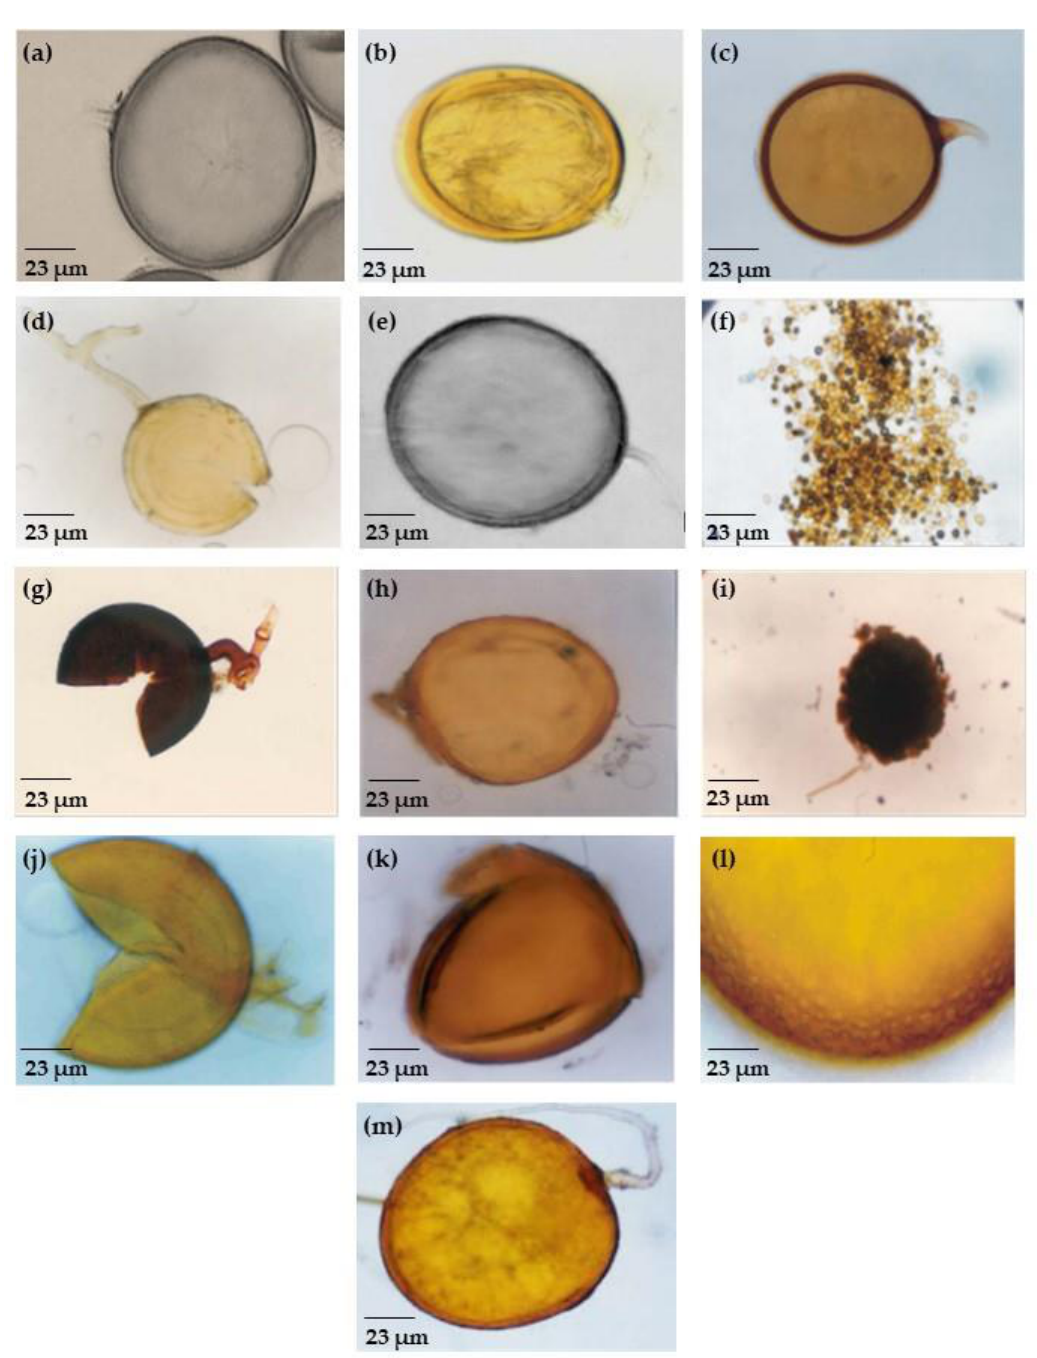
Figure 2. Morphology of some AMF species isolated from coffee roots. ( a ) C. etunicatum , ( b ) F. geosporum , ( c ) F. coronatum , ( d ) R. clarum , ( e ) R. intraradices , ( f ) R. microaggregatum , ( g ) S. constrictum , ( h ) D. versiformis , ( i ) Gl. dussii , ( j ) A. rugosa , ( k ) A. mellea , ( l ) A. foveata , and ( m ) G. gigantea .